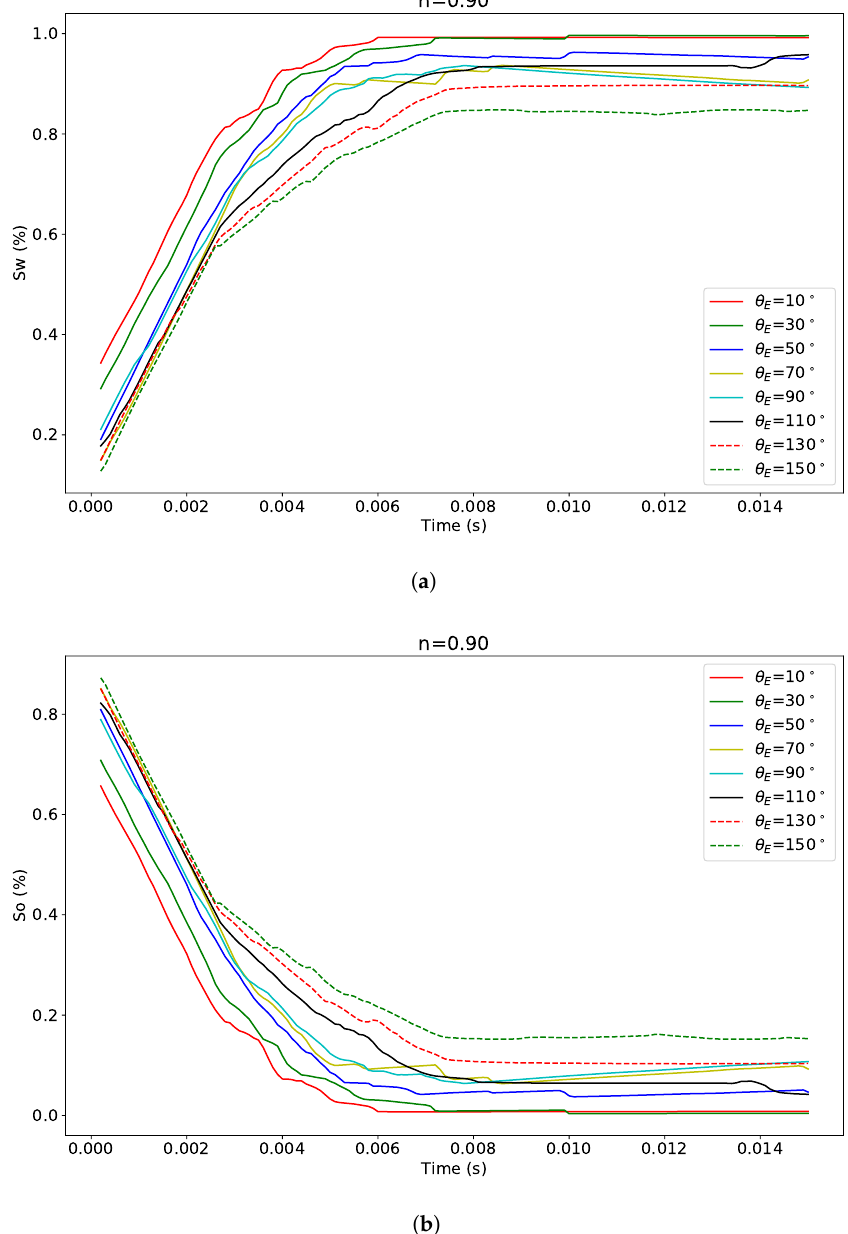
Figure 15. Temporal evolution of ( a ) polymer solution in water and ( b ) oil saturations at different contact angles for a non-Newtonian fluid, n = 0.9 and χ = χ 0